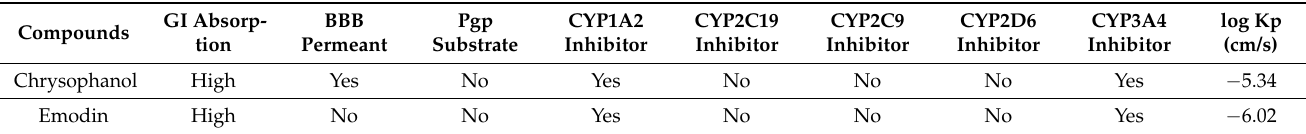
Table 6. Toxicity prediction. Data obtained from pkCSM server (http://biosig.unimelb.edu.au/ pkcsm/theory, accessed on 18 January 2022). Table 5. ADME prediction from SwissADME (GI = Gastrointestinal, BBB = Blood-brain barrier, Pgp = P glycoprotein, CYP = Cytochrome, log Kp = skin permeation).